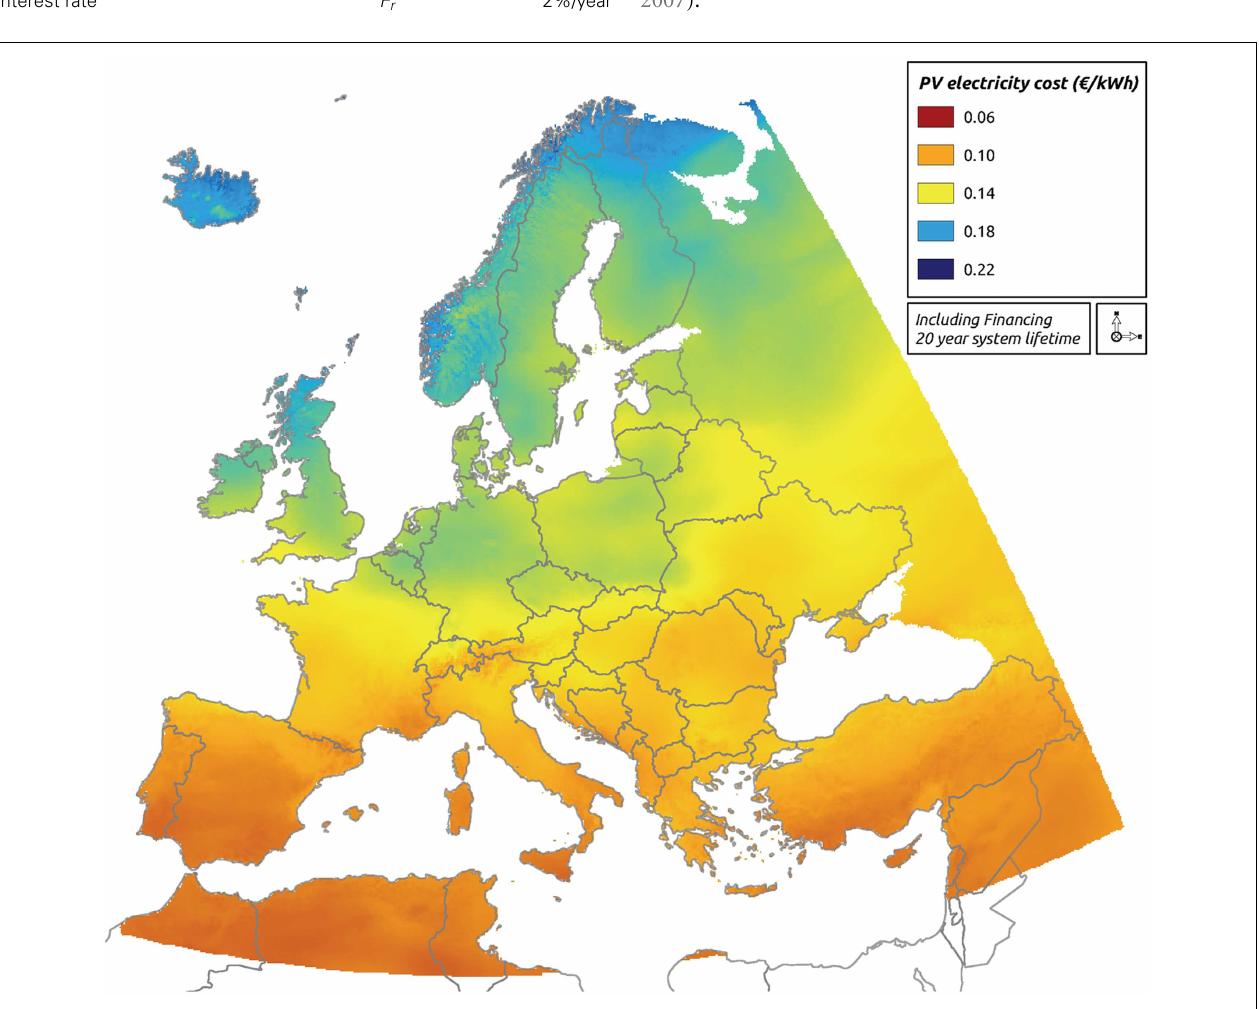
FIGURE 3 | PV electricity cost in Europe including financing for a 20-year system lifetime